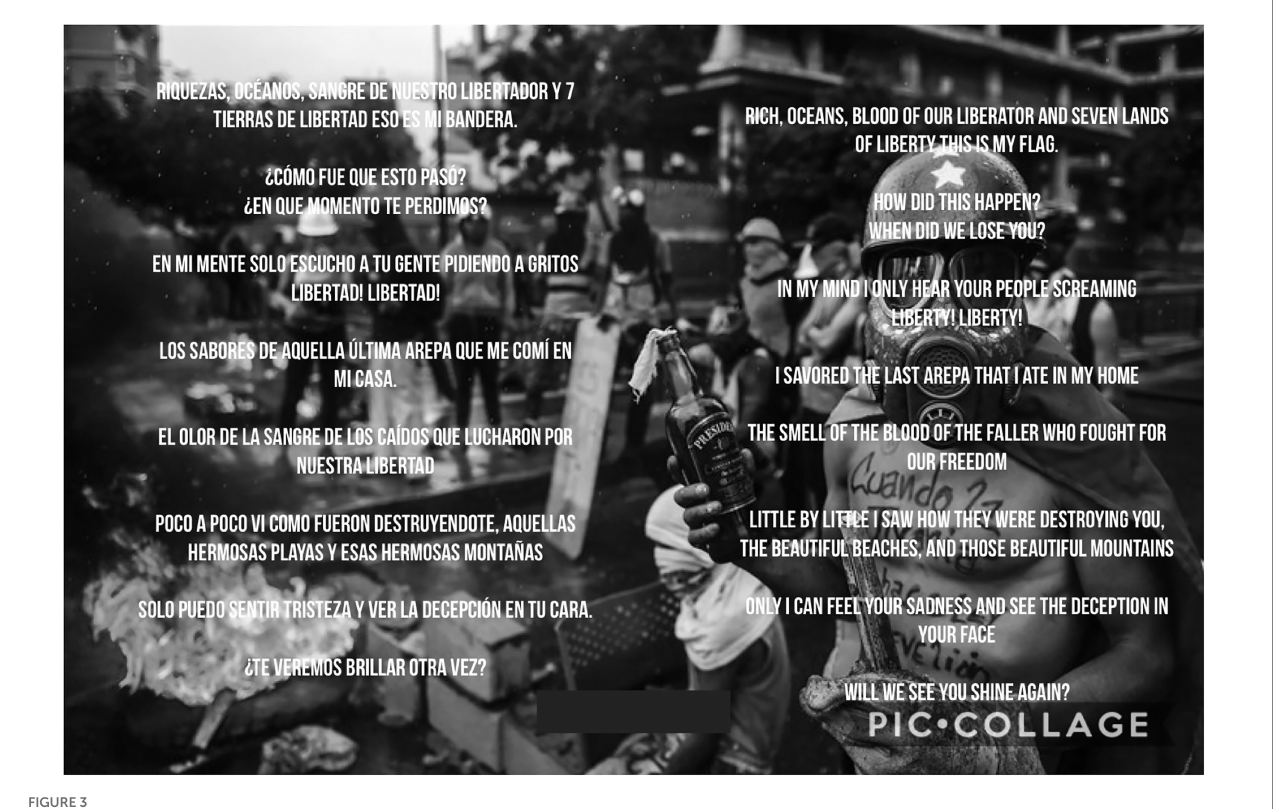
FIGURE 3 Venezuela